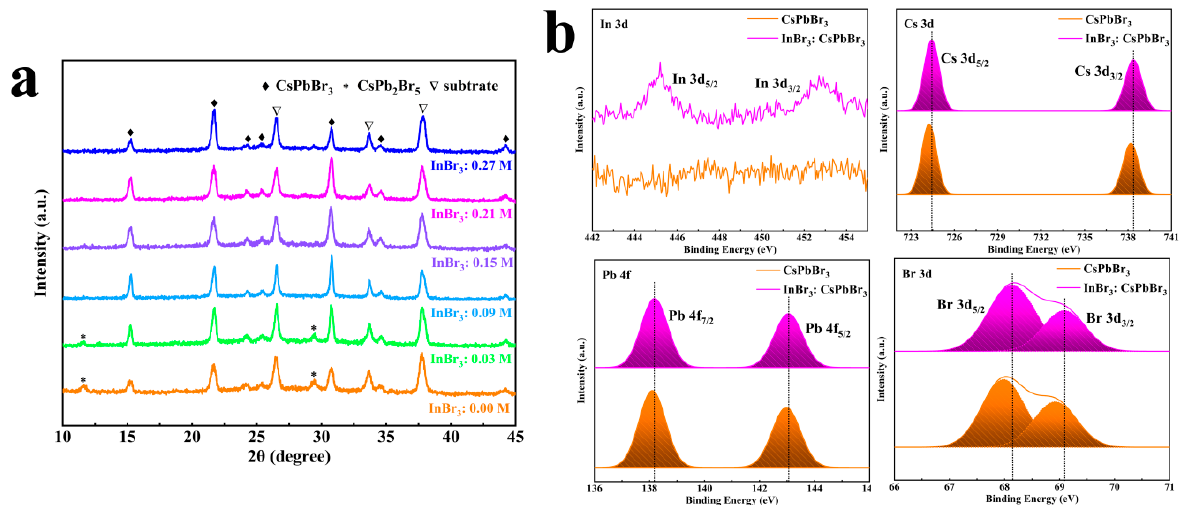
Figure 4. ( a ) XRD patterns of CsPbBr 3 films by introducing different concentrations of InBr 3 . ( b ) In 3d, Cs 3d, Pb 4f, Br 3d XPS core spectra of InBr 3 :CsPbBr 3 film.